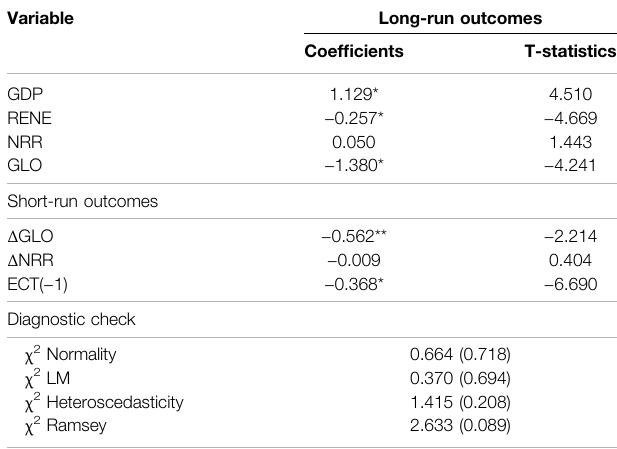
TABLE 5 | ARDL estimators